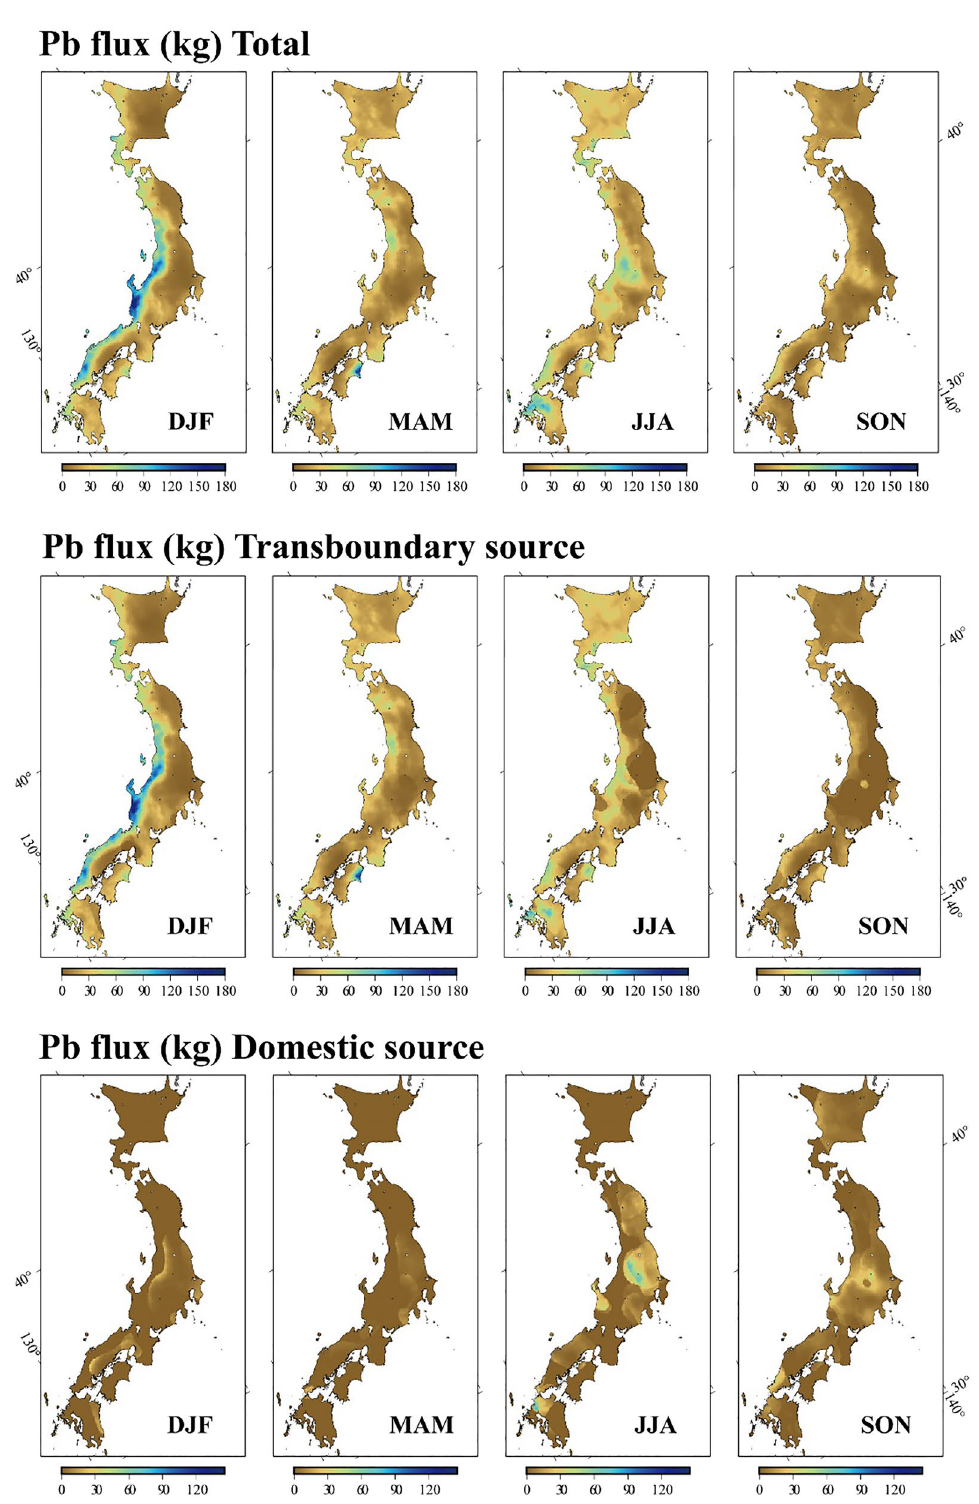
Figure 4. Pb flux over Japanese archipelago. Maps showing spatiotemporal changes in calculated Pb flux in 2013 from different sources. “Total” means combined Pb fluxes from transboundary and domestic sources. All maps were drawn by using GMT (Version